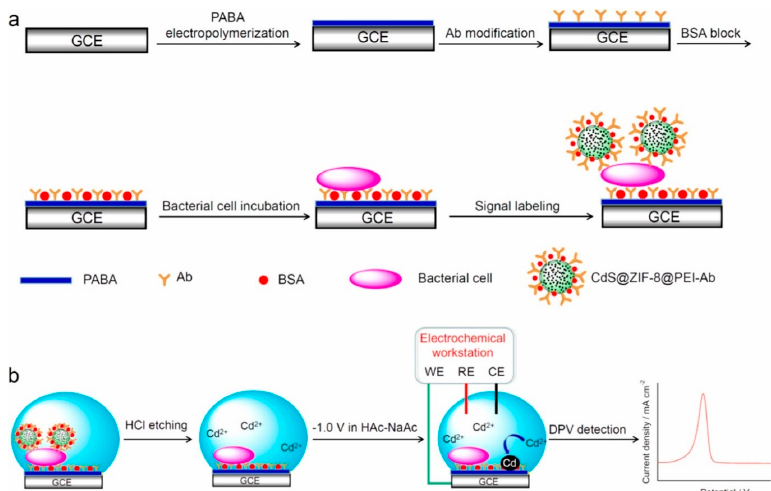
Figure 1. ( a ) Schematic diagram of the fabricated steps of the electrochemical biosensor for E. coli O157:H7 using CdS@ZIF-8 as signal tags, ( b ) Illustration of the detection steps by DPV. (GCE, glassy carbon electrode; PABA, Poly( p -aminobenzoic acid); Ab, antibody; BSA, bovine serum albumin; Cds, cadmium sulfide quantum dots; ZIF-8, zeolitic imidazolate framework-8; PEI, polyethyleneimine; WE, working electrode; RE, reference electrode; CE, counter electrode; HCL, hydrochloric acid; DPV, differential pulse voltammetry) [59] . Biosensors 2020 , 10 , x